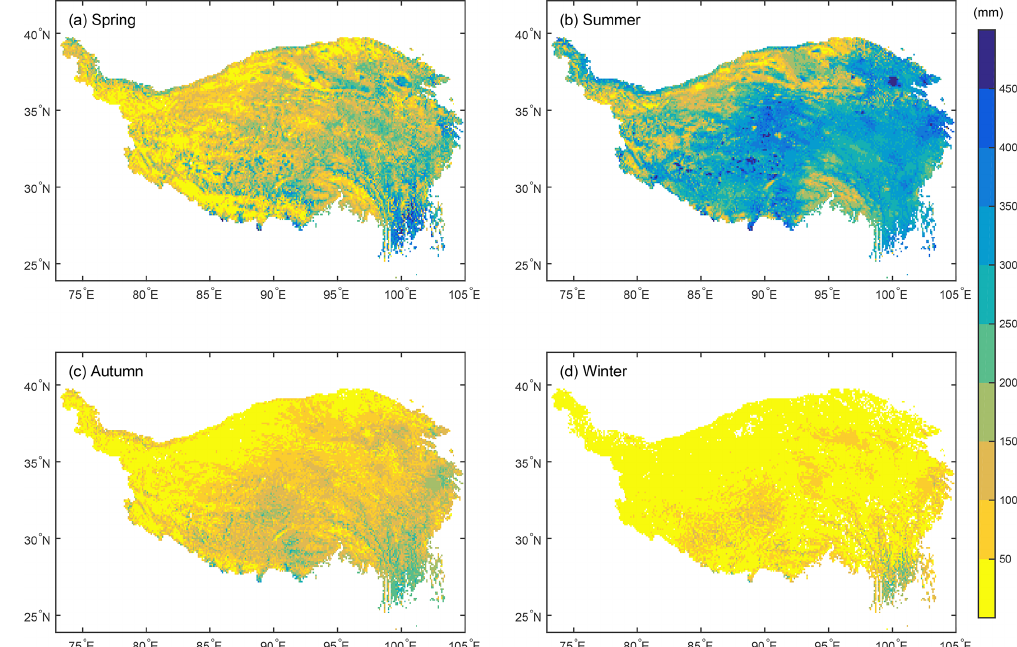
Figure 4. Spatial distributions of the SEBS-estimated multiyear (2001–2018) average seasonal ET a (millimeters per season) values over the TP. (a) Spring, (b) summer, (c) autumn, (d) winter.